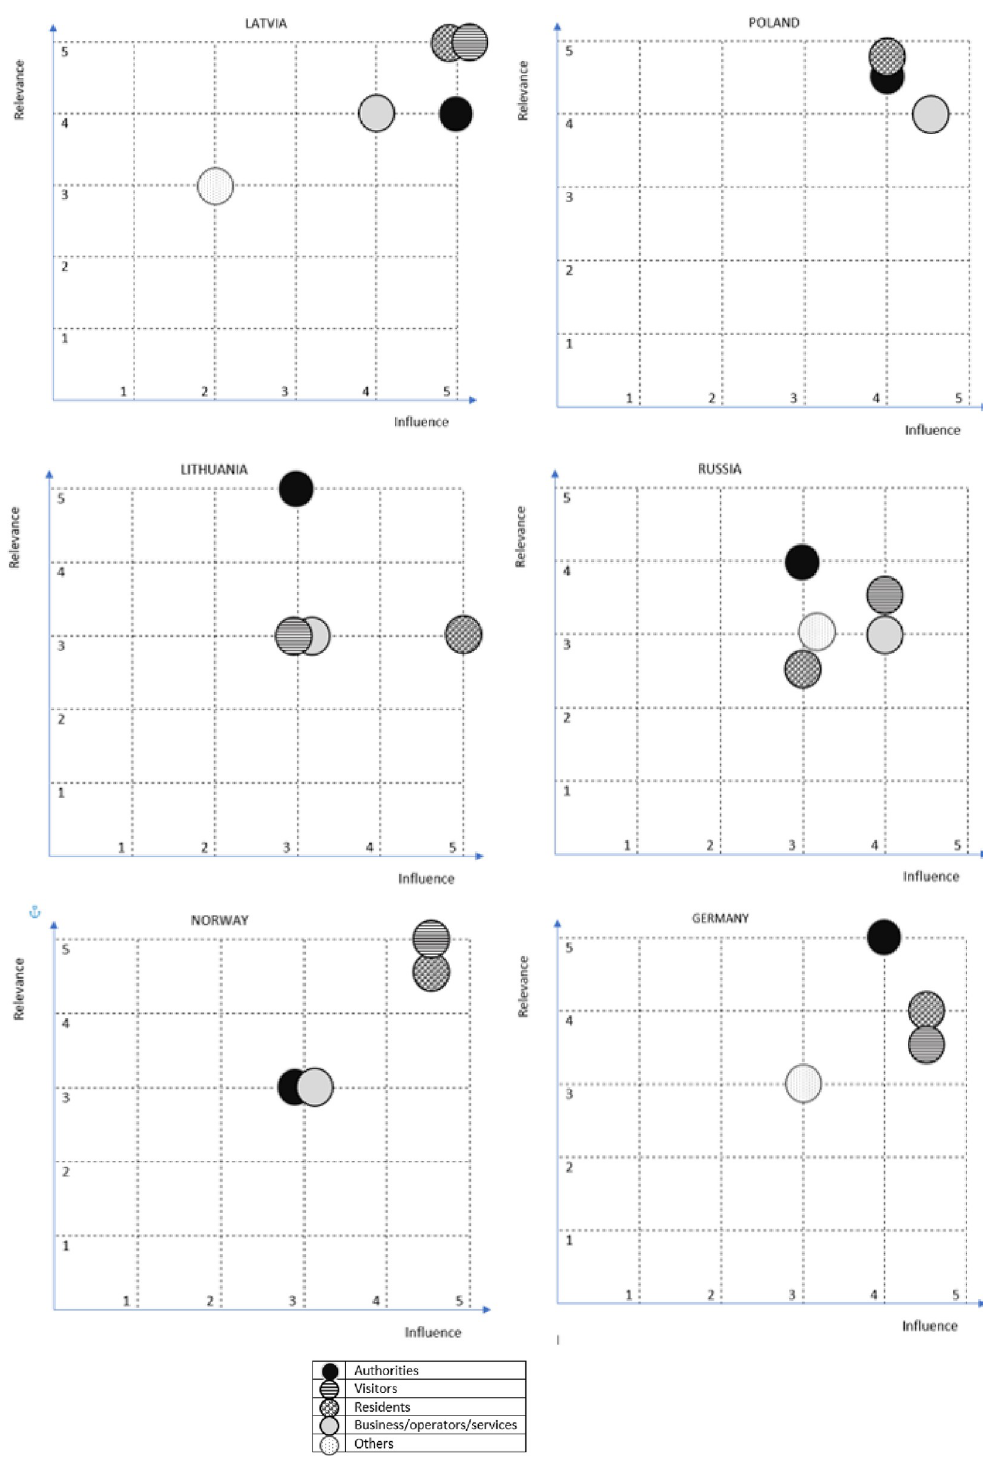
Fig 4. Influence of stakeholders and the relevance of the project in six regions. Source: Own study.